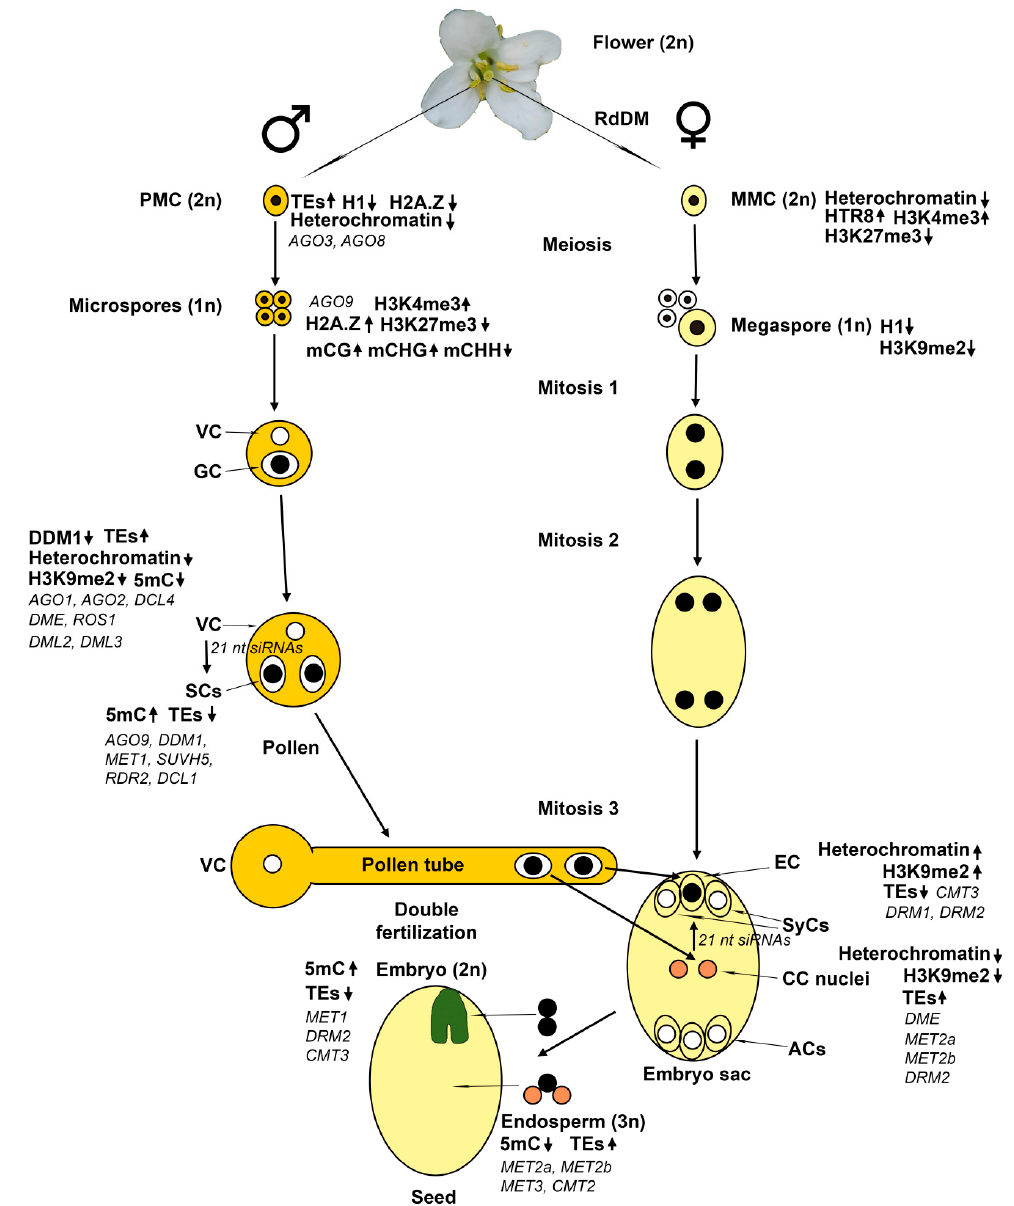
Figure 1. Key events in plant gametogenesis. PMC—pollen mother cell, MMC—megaspore mother cell, RdDM—RNA directed DNA methylation, VC—vegetative cell, GC—generative cell, SCs—sperm cells, EC—egg cell, SyCs—synergid cells, CC—central cell, ACs—antipodal cells. Increases or decreases in epigenetic features are shown by arrows pointing upwards or downwards, respectively. Genes actively expressed are shown in italics.